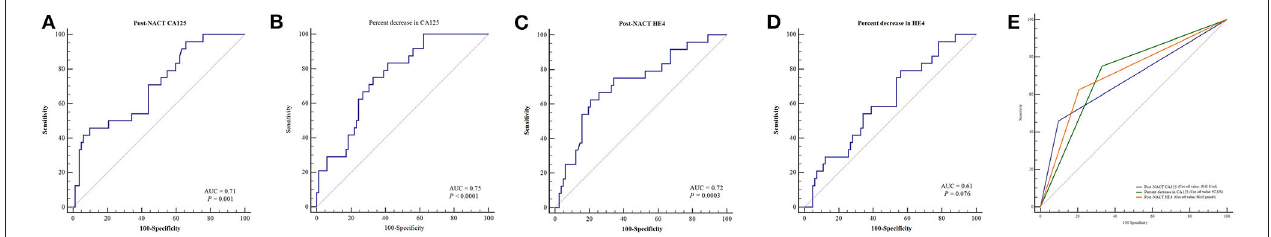
FIGURE 1 | ROC curves to predict CRS 3 following NACT. (A) Post-NACT CA125. (B) Percent decrease in CA125. (C) Post-NACT HE4. (D) Percent decrease in HE4. (E) Comparison of AUCs. AUC, areas under the curve; CRS, chemotherapy response score; HE4, human epididymis protein 4; NACT, neoadjuvant chemotherapy; ROC, receiver operating